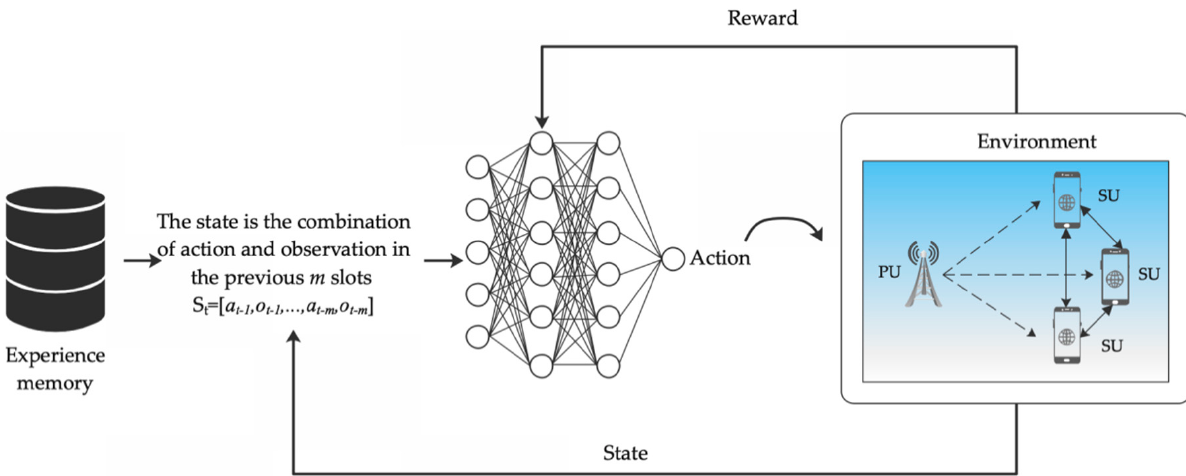
Figure 3 . The framework of deep Q network (DQN). Figure 3. The framework of deep Q network (DQN).